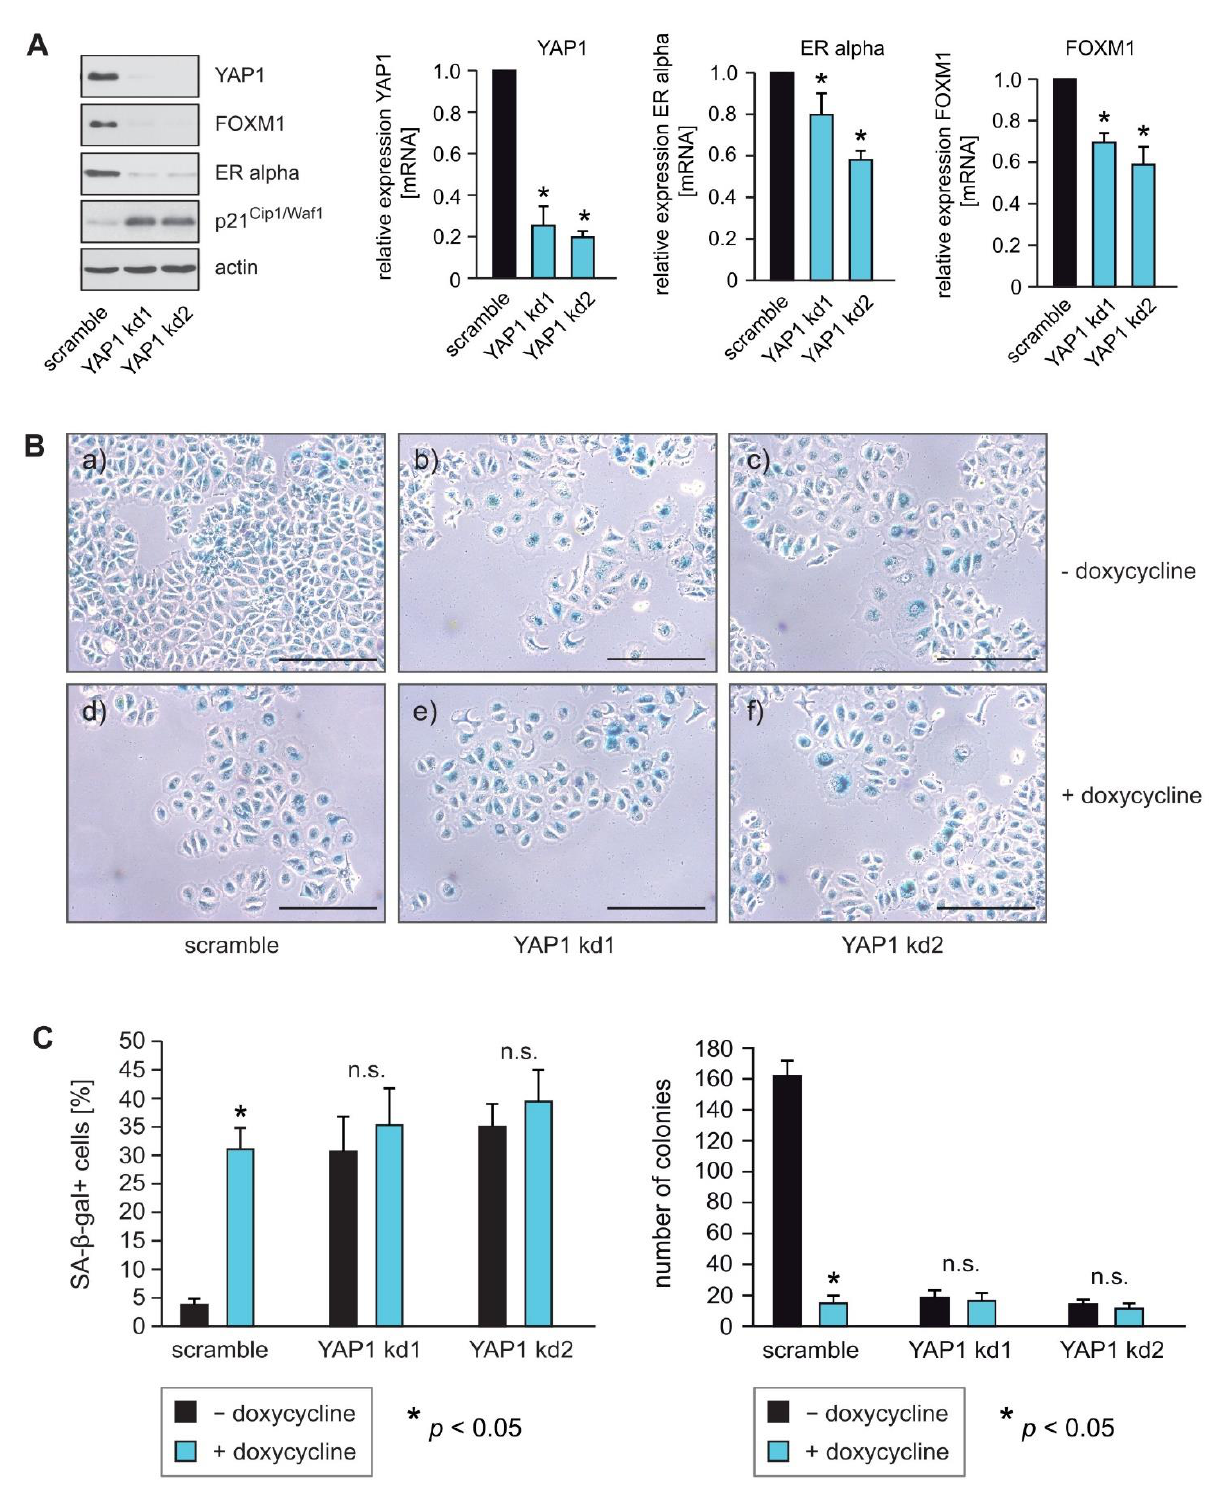
Figure 2. YAP1 knockdown phenocopies the effects of RASSF1A. ( A ) Stable knockdown of YAP1 was performed in conditional MCF7 cells using shRNAs (YAP1 kd1 and YAP1 kd2). Cell extracts were prepared 48 h after lentiviral transduction. Western blots of lysates from the two independent YAP1 shRNAs (YAP1 kd1 and YAP1 kd2) cells were probed with the indicated antibodies (left panel). Knockdown of YAP1 in MCF7 cells using the shRNAs YAP1 kd1 and YAP1 kd2 was performed and mRNA was prepared 48 h after lentiviral transduction. Transcript levels of the indicated genes were analyzed by quantitative PCR. Mean values ± s.d. of three independent experiments are presented. p -Value < 0.05